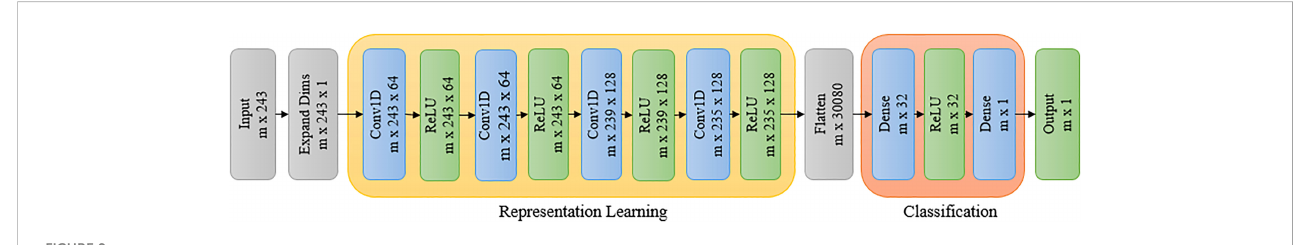
FIGURE 9 Deep learning architecture for classi fi cation of stressed and unstressed pixels.